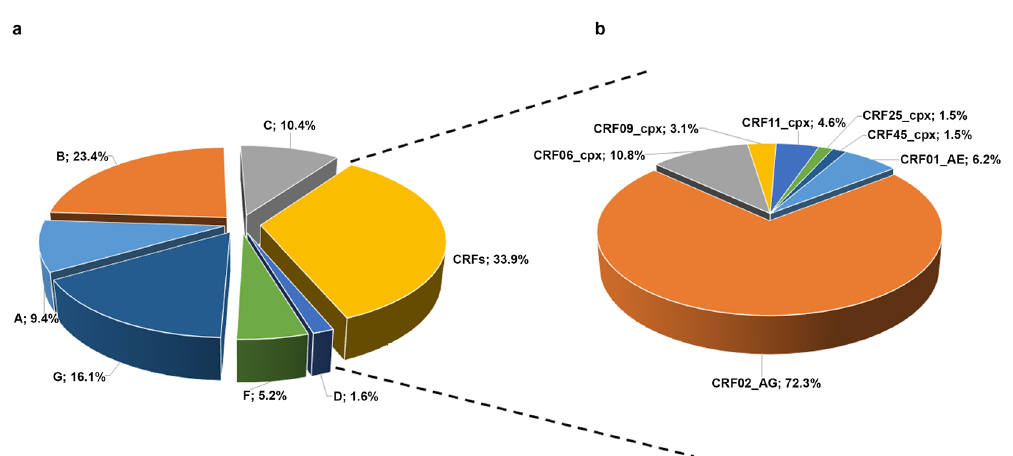
Figure 2. Prevalence of HIV-1 subtypes and recombinant forms in 192 immigrants resident in Italy. The prevalence of the genetic forms is expressed as the percentage of the total